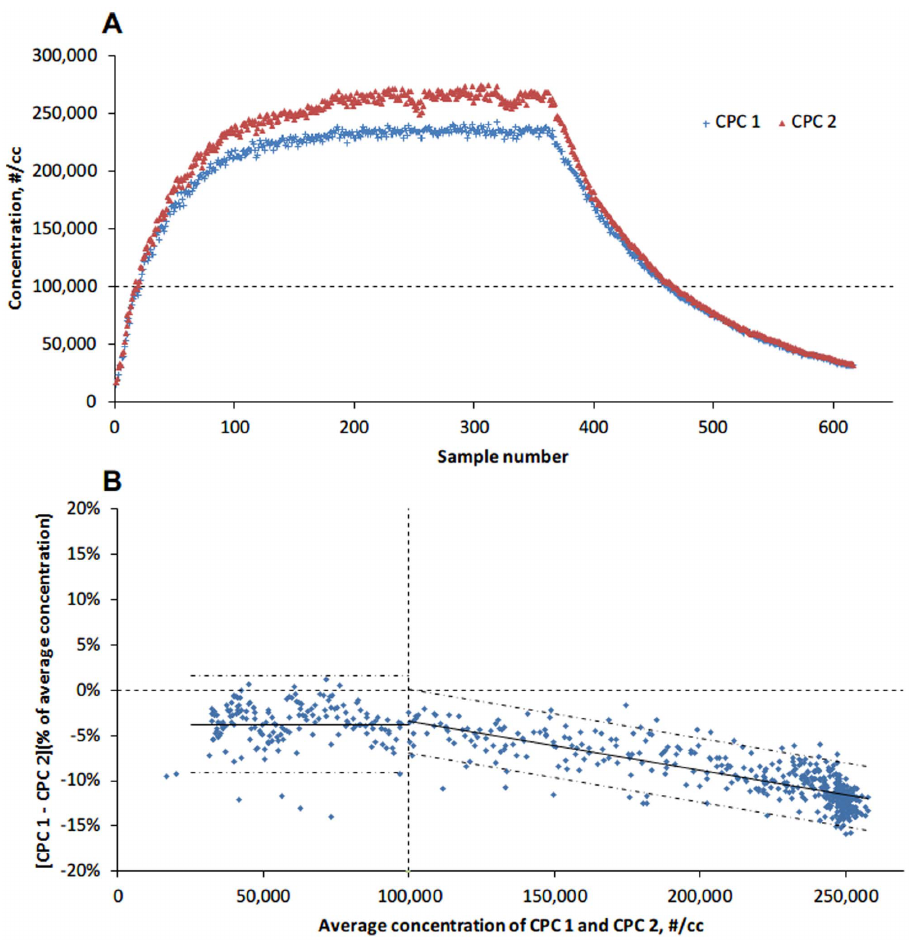
Figure 1. Comparison of two Condensation Particle Counters (CPCs) below and above their dynamic upper limits (100,000 # /cc). The solid lines indicate mean percent difference; the dot-dashed lines indicate 6 1.96 standardized deviations (SD) around the mean percent difference; the vertical dashed line represents the CPC’s dynamic upper limit; the horizontal dashed line in A represents the CPC’s dynamic upper limit; the horizontal dashed line in B represents a percent difference of 0.